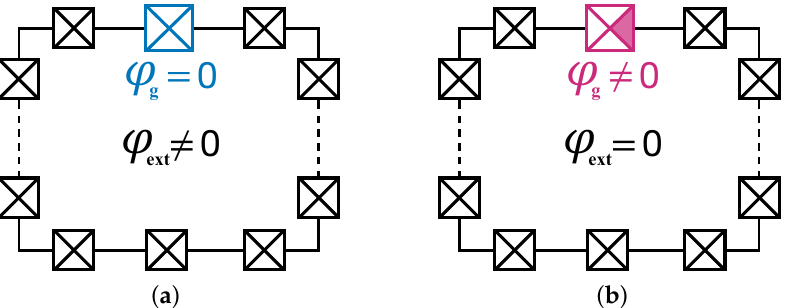
Figure 2. ( a ) Fluxonium-type qubit based on conventional Josephson junction inductively shunted by a series of Josephson junctions. The qubit is biased by an external magnetic flux ϕ ext ≡ 2 π Φ / Φ 0 , where Φ 0 is the elementary flux quantum. The gate phase offset for a conventional Josephson junction is absent, ϕ g = 0. ( b ) Chiral magnetic qubits based on the Chiral Magnetic Josephson (CMJ) junction are inductively shunted by a series of Josephson junctions. The CMJ junction possesses an internal phase offset ϕ g (cid:54) = 0 eliminating the need for an external magnetic flux ϕ ext